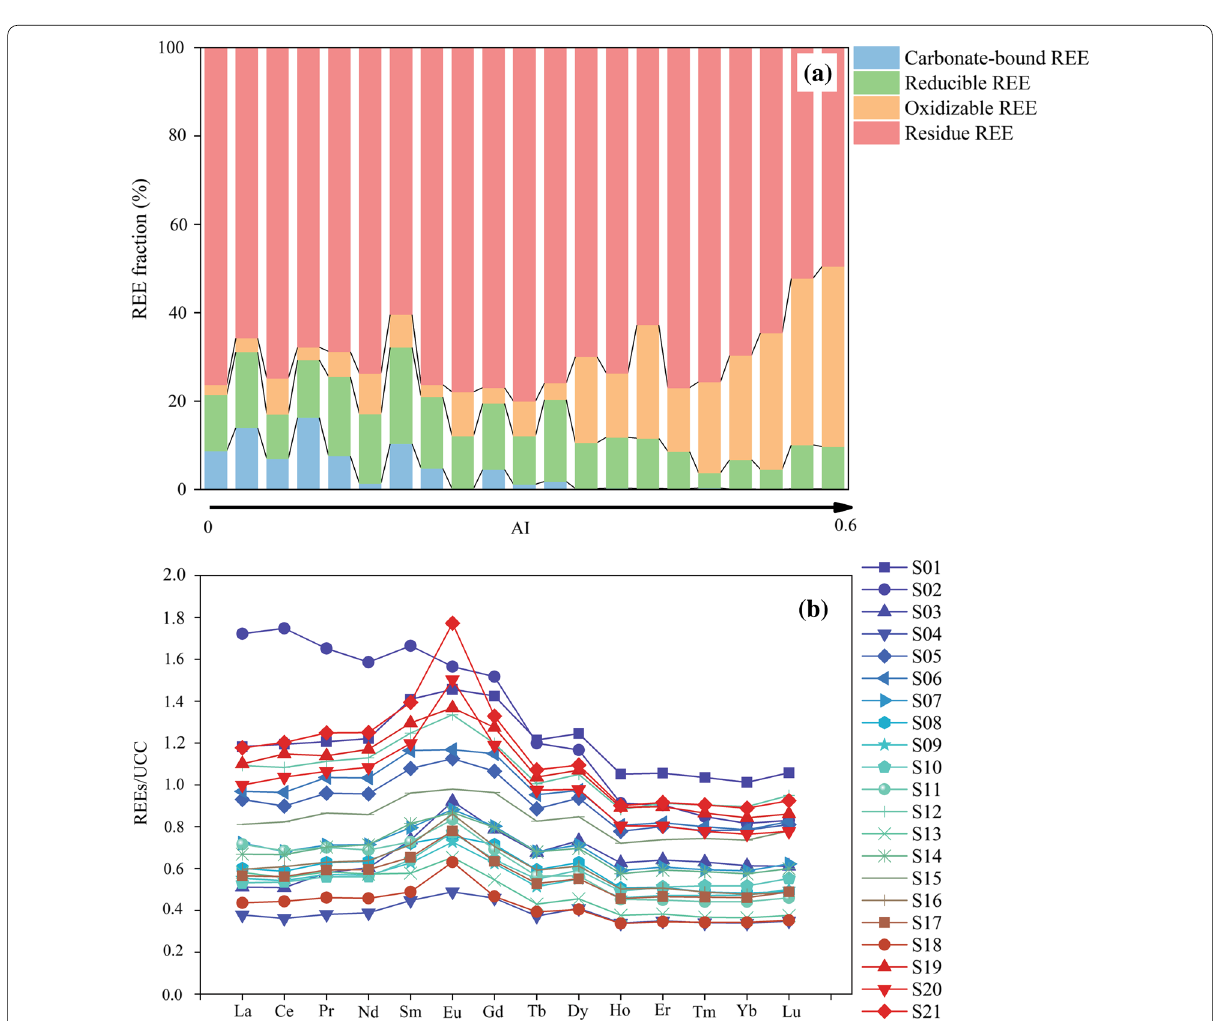
Fig. 2 a Relative geochemical fractions (carbonate‑bound, reducible, oxidizable and residue) of rare earth elements (REE) vs. aridity index (AI) in topsoils (0–10 cm). b Upper continental crust (UCC) normalized patterns of bulk REE in topsoils (0–10 cm) along the northern China transect